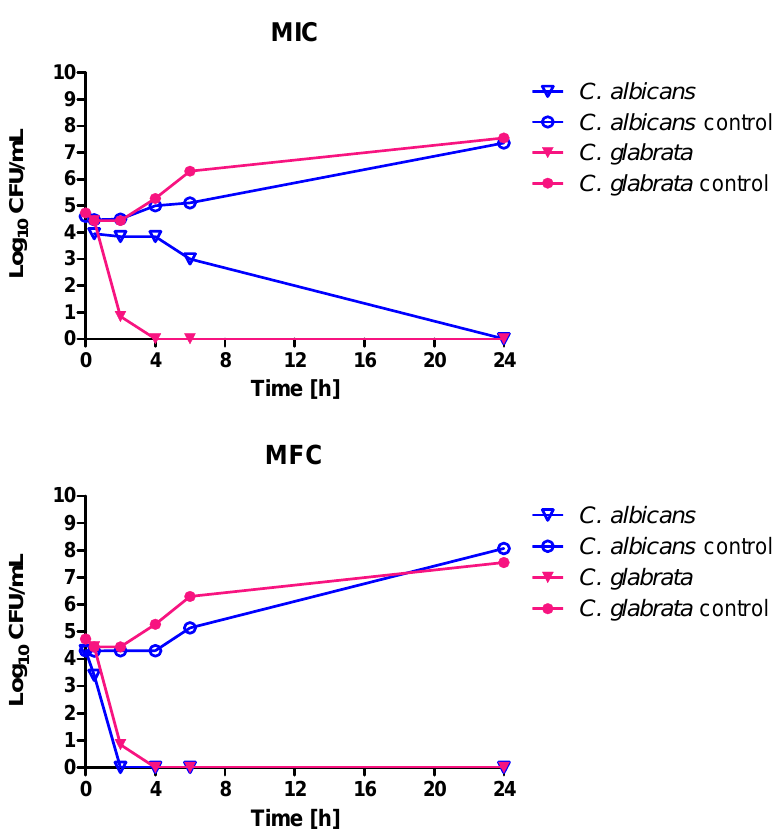
Figure 2. Kinetic of C. albicans ATCC 10231 and C. glabrata DSM 11226 growth under the influence of cinnamon oil in the concentrations equal to 0.016% ( v/v ) (MIC) or 0.031% ( v/v ) (MFC).